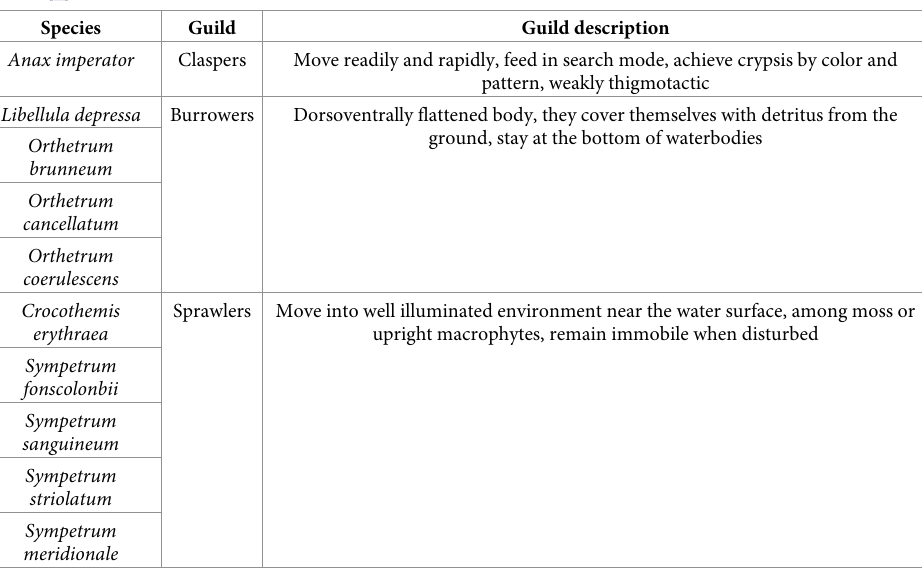
Table 1. List of Dragonfly species collected during the surveys and description of guild where they belong. Species collected are grouped in ecological guilds. For each guild, we provided a brief description of the main features following Corbet